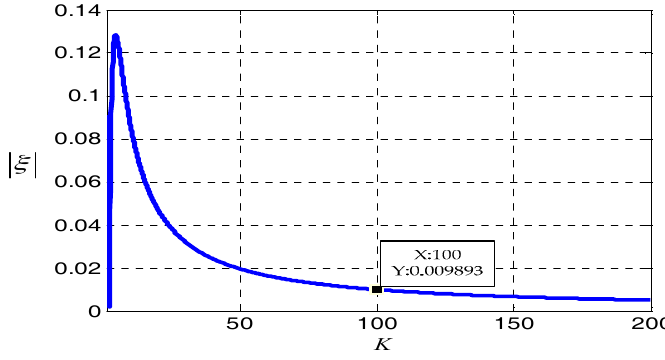
Figure 10. The variation of modulation angular rate error coefficient.